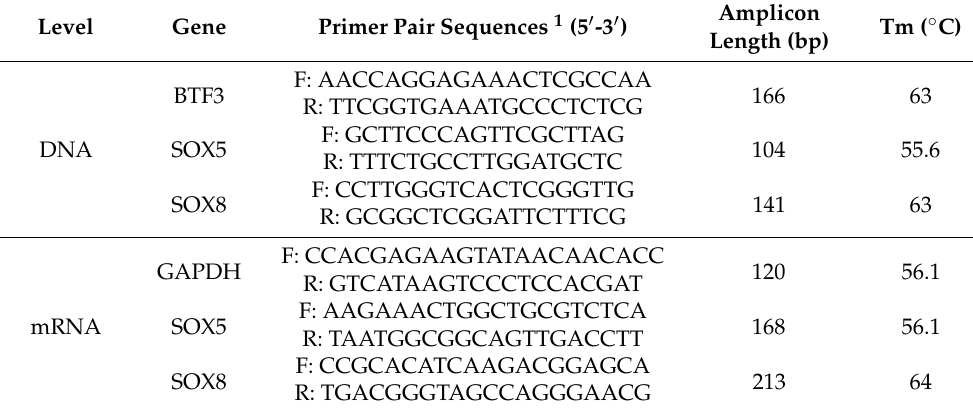
Table 1. Primer information.